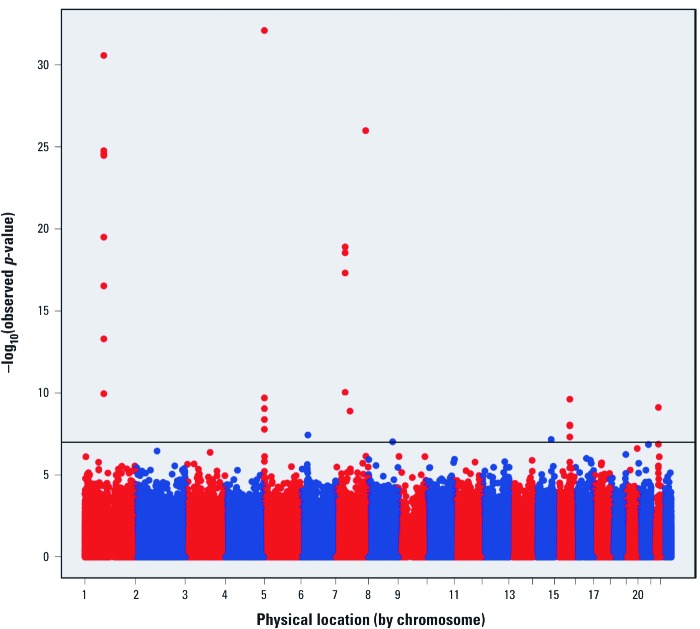
Epigenome-wide association between maternal cotinine and methyla­tion of 473,844 CpGs ­measured in cord blood from the MoBa cohort. Twenty-six CpGs (10 genes) reached Bonferroni-corrected statistical significance (p < 1.06 × 10–7, represented by the horizontal line). Red and blue alternating colors are used to distinguish between chromosomes.